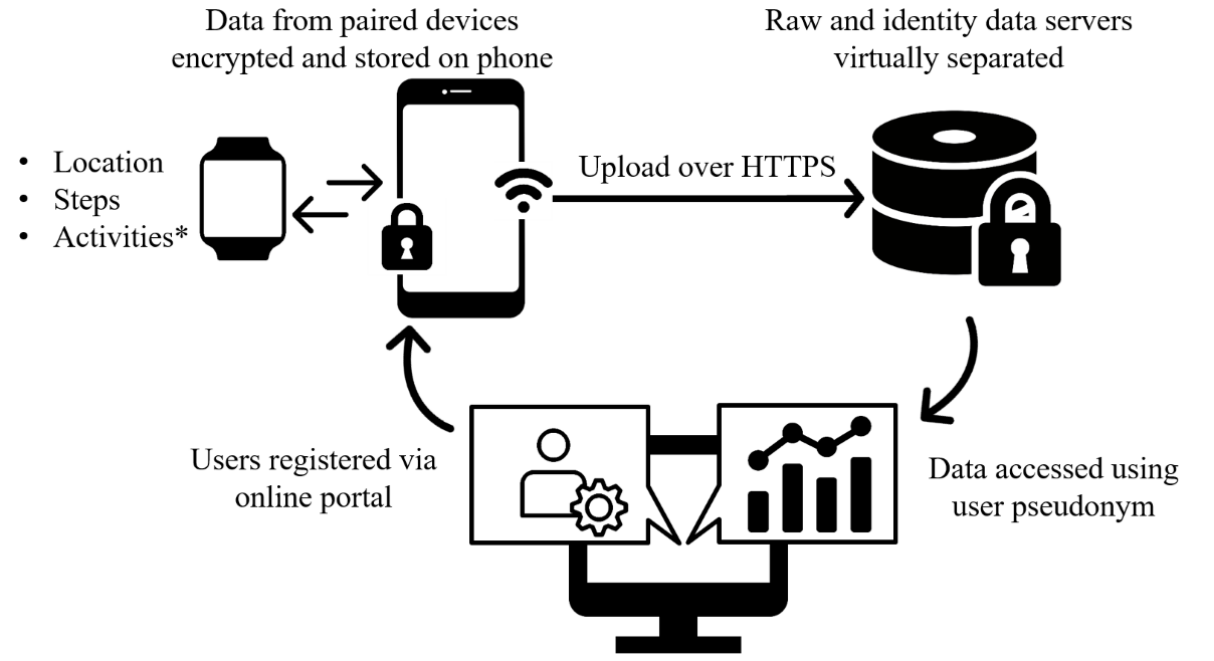
Figure 5. Data collection setup: data is collected using sensors on-board a smartwatch and smartphone (*activities collected using the phone only), encrypted and stored locally on the phone then transferred securely to a server from where it is accessed by an